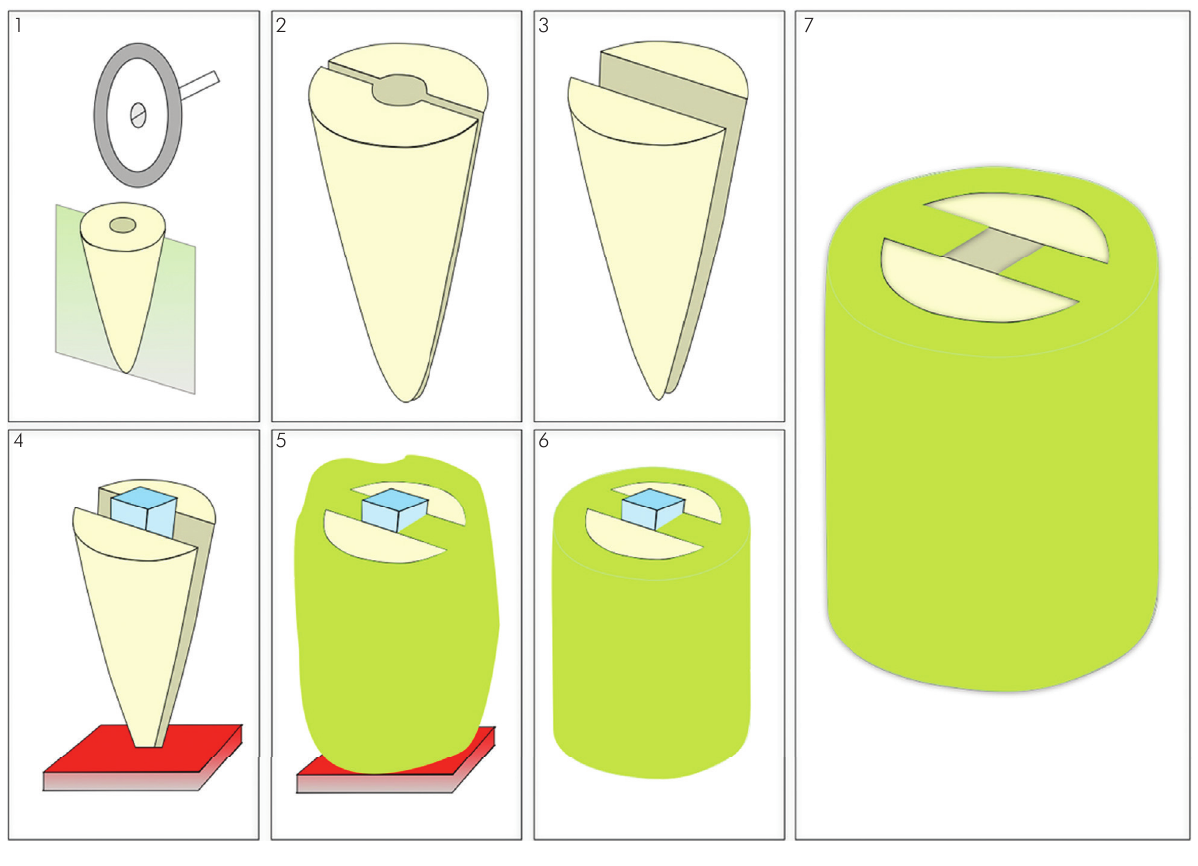
Figure 1. Representative design of dentin sample preparation using impression material in order of fabrication. 1. Longitudinal sectioning of the root with a rotary diamond disk, 2. Dentin samples, 3. Polished samples, 4. Acrylic bar between samples, 5. Preparation and placement of impression material, 6. Removal of excess impression material, wax, and acrylic bar, 7. Final samples embedded in impression material and covered with a white sealing